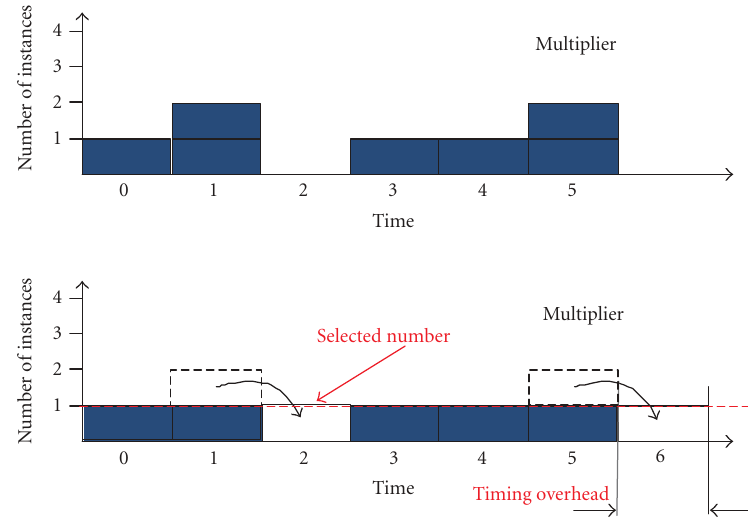
Figure 6: Balancing the number of instances of multiplier for given timing overhead.